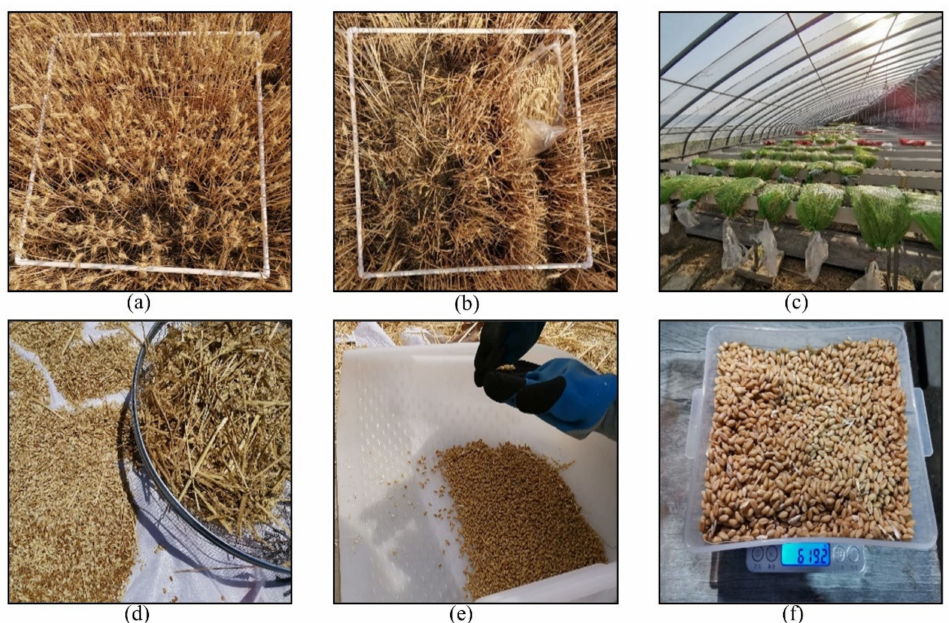
Figure 2. Process of wheat yield acquisition. ( a ) Determination of 1 m × 1 m sampling squares. ( b ) Harvest of the wheat in sampling squares. ( c ) Drying of the sampled wheat. ( d ) Threshing of the sampled wheat. ( e ) Removal of impurities from the threshed wheat. ( f ) Determination of dry weight of the sampled wheat.